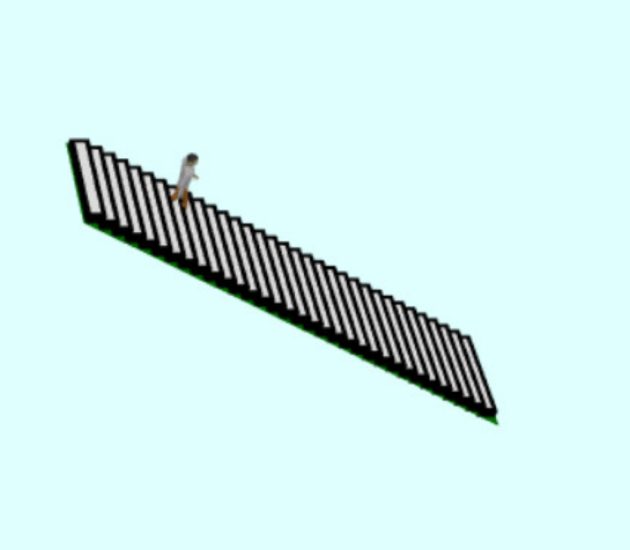
Figure A3. The scenario of test 3. Test 4: Exit flow rate.